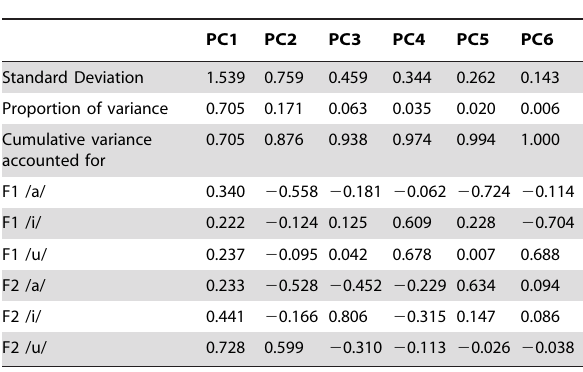
analysis is summarized in Table 3. Female Voice PC1 represented 64.7% of the variance in the voice quality measures; Voice PC2 also accounted for a relatively large amount of the variance, nearly 25%. Voice PC3 through PC7 represented considerably less of the variance, and combined their contributions brought the model up to 100%. PC8 and PC9 provided very small contributions with shimmer and jitter weighted heavily for these higher components. From a general perspective, the male voice quality analysis is superficially similar to the females’, and is summarized in Table 4. The male Voice PC1 accounted for 69% of the variance in the Table 2. The cumulative proportion of variance accounted for and loadings from the PCA of vowel quality from F1/F2 measures.